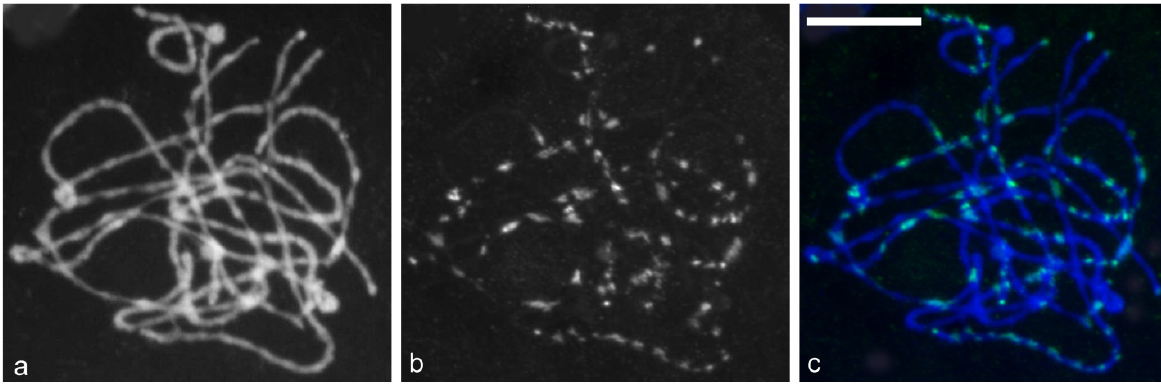
Figure 4. FISH analysis of Gypsy-Ty3 retrotransposons distributed on pachytene chromosomes of E. sagittatum ; ( a ) DAPI stained chromosomes; ( b ) Dispersed signal; ( c ) Merged images. Scale bar = 10